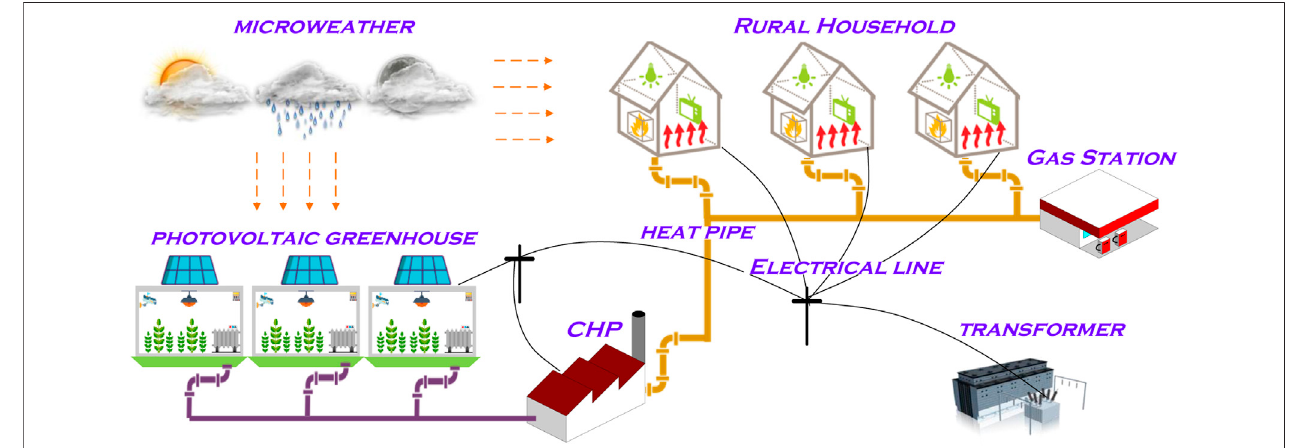
FIGURE 1 | Schematic diagram of the typical AEI consisting of agricultural and energy